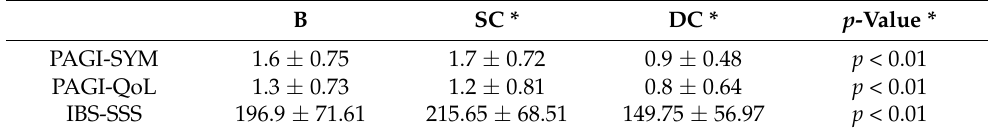
Table 5. PAGI-SYM, PAGI-QoL and IBS-SSS total scores changes in basal conditions and during SC and DC Treatment Periods. Data are presented as mean ± SD.